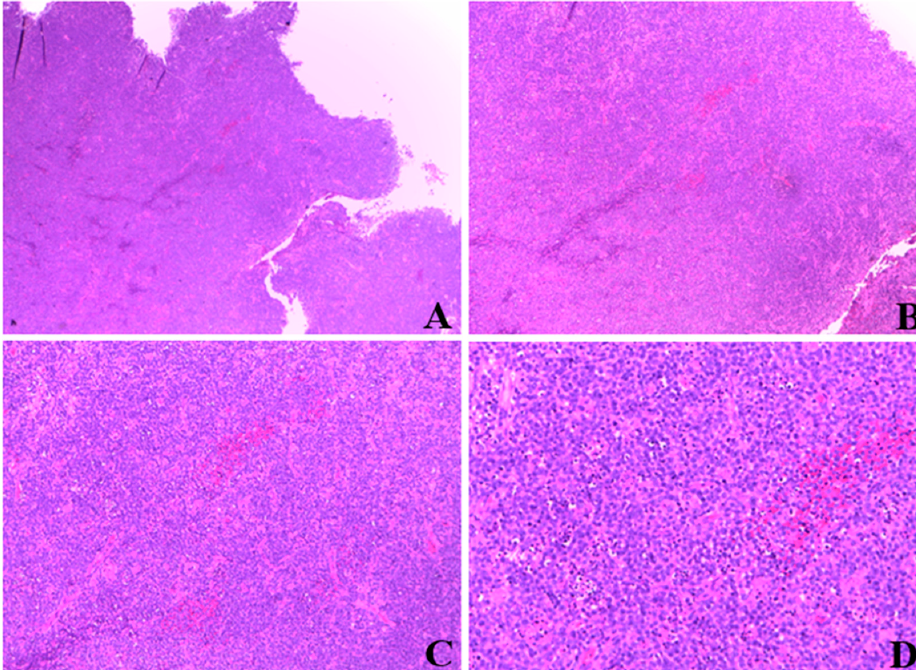
Figure 1. Magnification of cervical mass biopsy. ( A ): 2.5 × . ( B ): 5 × . ( C ): 10 × . ( D ): 20 ×